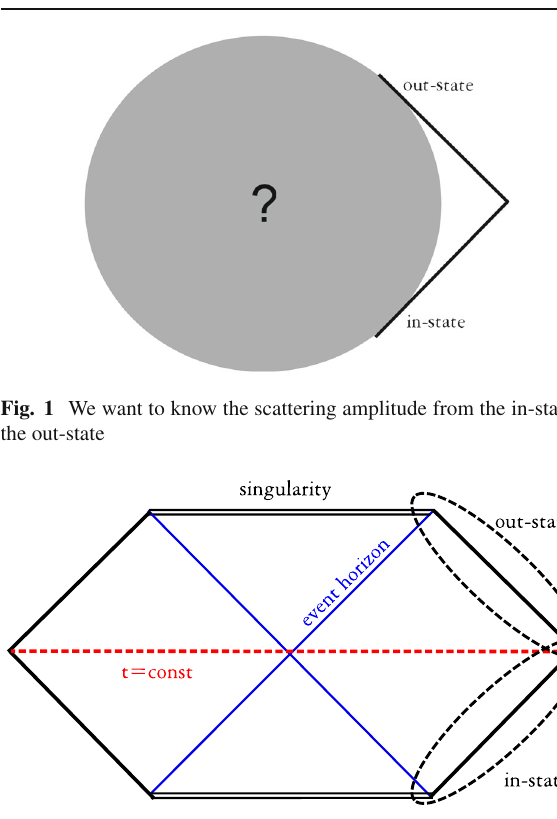
Fig. 2 The intermediate geometry will be well-approximated by the maximally extended